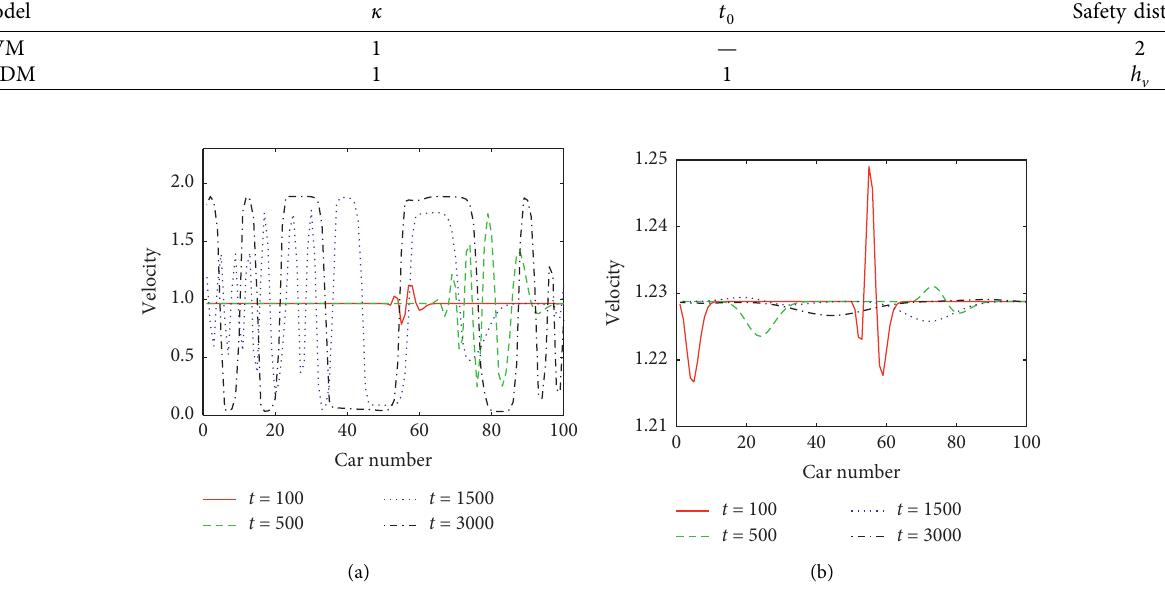
Figure 5: Profiles of velocities at time step t � 100, 500, 1500, and 3000 when κ is a constant. (a) OVM. (b) DSDM.